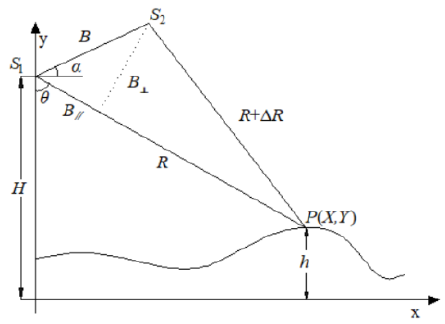
Figure 2. Schematic diagram of interferometric imaging.